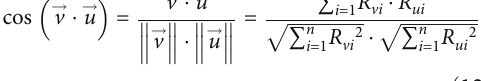
Table 3: Comparison of MAE values between new and classical fi tness functions.